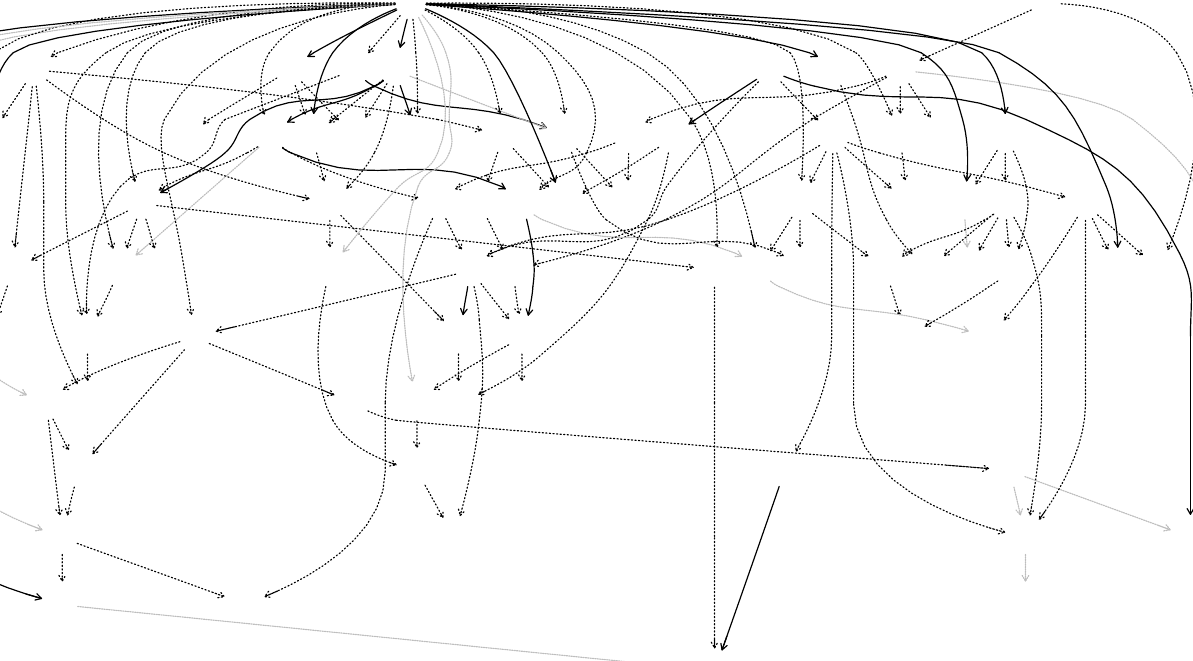
Fig 1. Network structure learned using Bayesian network inference. Only significant links are presented, and grey lines indicating links with no sign was detected. Grey and black circles represent species with a Quaternary and Tertiary syndrome respectively. White circles are either environmental variables (mean temperature in the warmest quarter of the year (Twarm), annual precipitation (anualP), soil types (soil), land use (landuse), orientation (orientation), dominant form (dom_form) and spatial location (spac)) or species with no syndrome associated. Continuous and dashed lines represent negative and positive associations respectively. Complete names for species are provided in the appendix and environmental variable categories in the methods